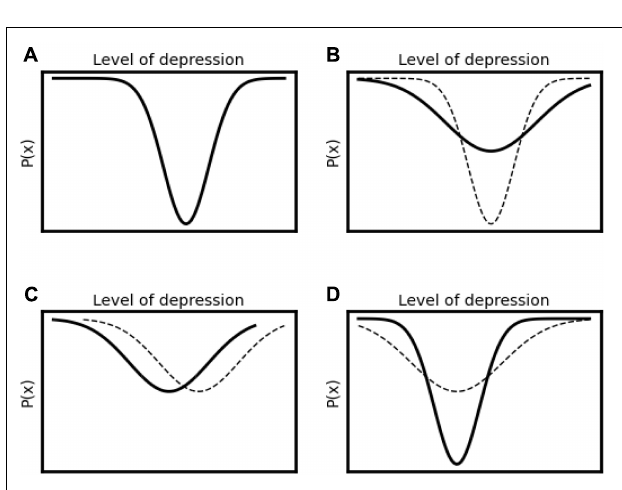
FIGURE 5 | A model of stages of therapeutic change presented in Tschacher and Haken (2019). (A) Prior to change, a deep basin of attraction, reflecting here a relatively stable depressive state. (B) A first stage of change, being a stochastic (chaotic) process involving a wider range of system states. (C) A deterministic change in system states in a particular (desired) direction, here toward a more positive range of emotions. (D) A reduction in stochastic